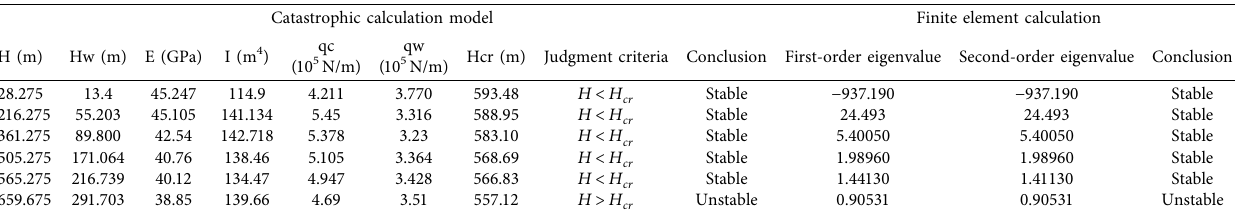
Table 2: Analysis comparison table between catastrophe model and finite element